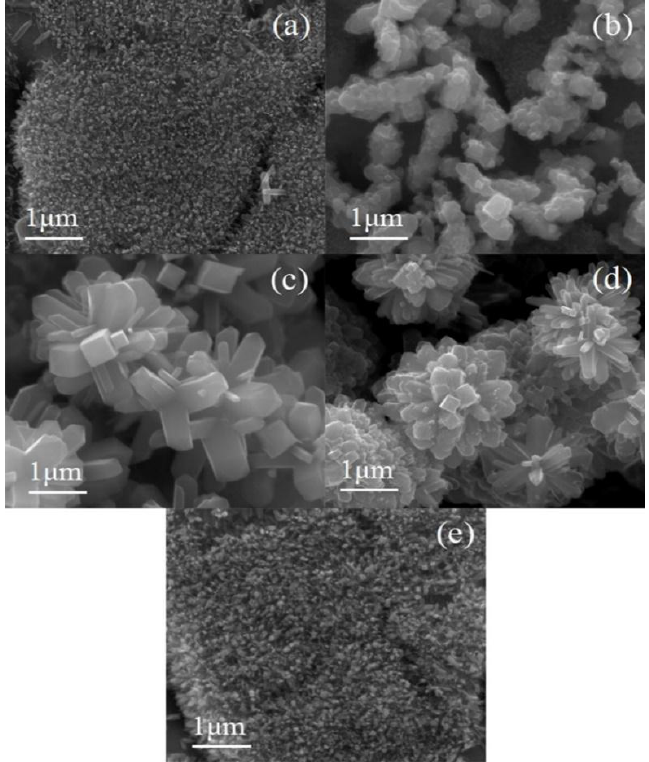
Figure 7. Scanning electron microscopy (SEM) images with different HCl concentration. ( a ) 0.3 mol/L; ( b ) 0.4 mol/L; ( c ) 0.5 mol/L; ( d ) 0.6 mol/L; ( e ) 0.7